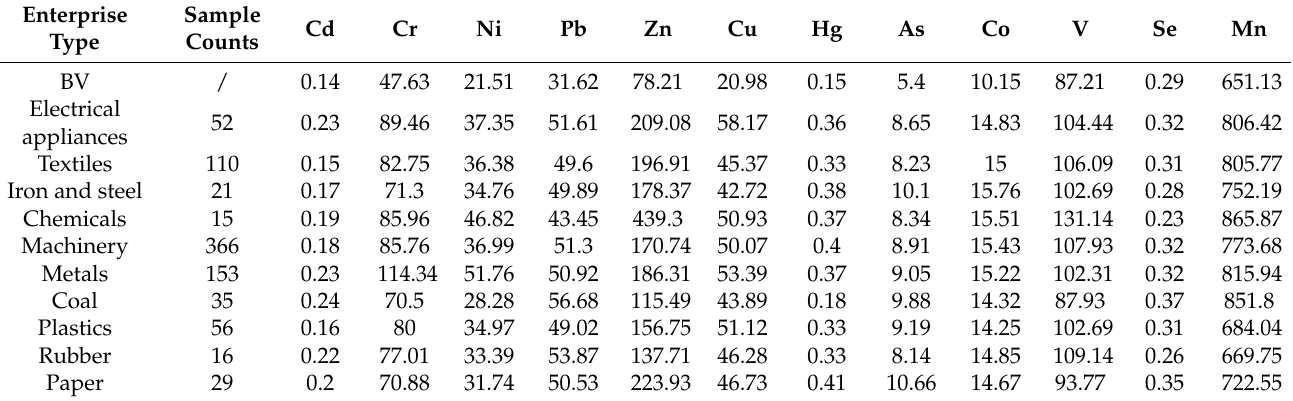
Table 4. Average concentrations of soil heavy metals around different types of industrial